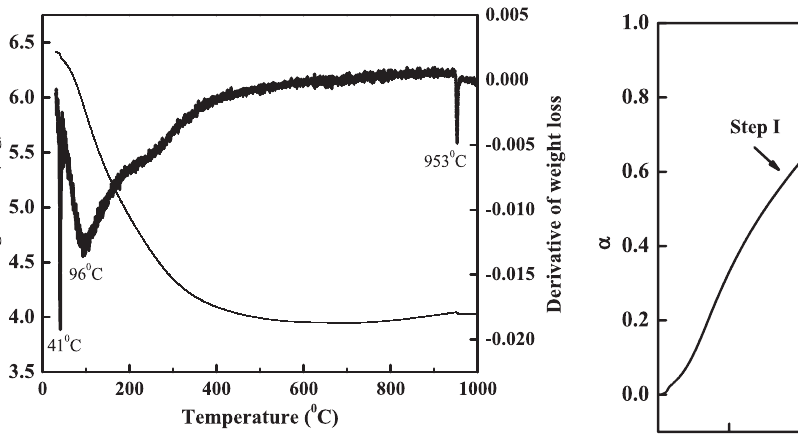
Fig. 5: Differential TG/DTA of the particles shown in Fig. 1A